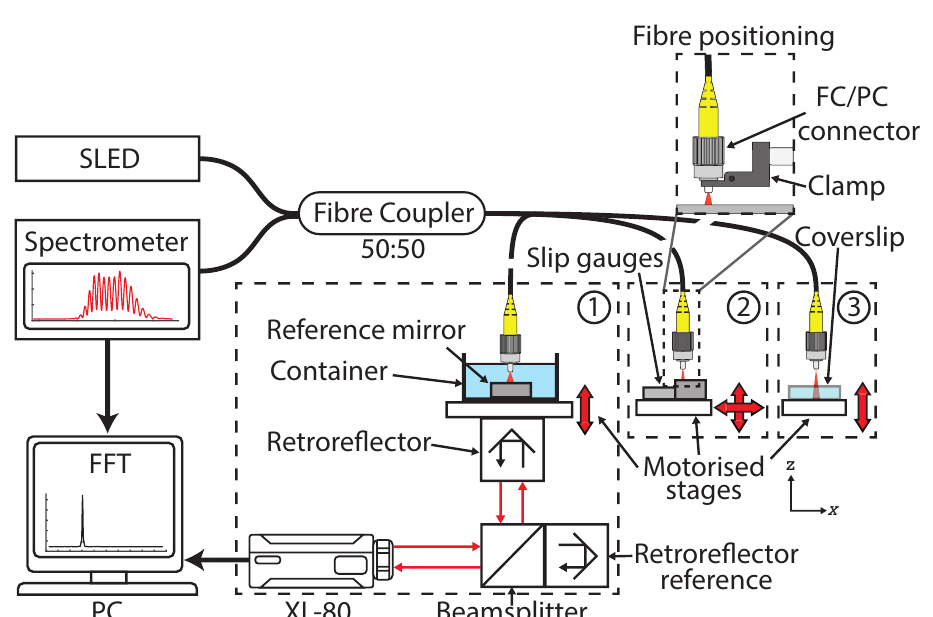
Figure 1. Experimental setup demonstrating all three calibration routines. (1) Calibration via Renishaw XL-80; (2) calibration via scanning across a calibrated step-height formed from slip gauges; and (3) calibration using a calibrated glass coverslip as a reference